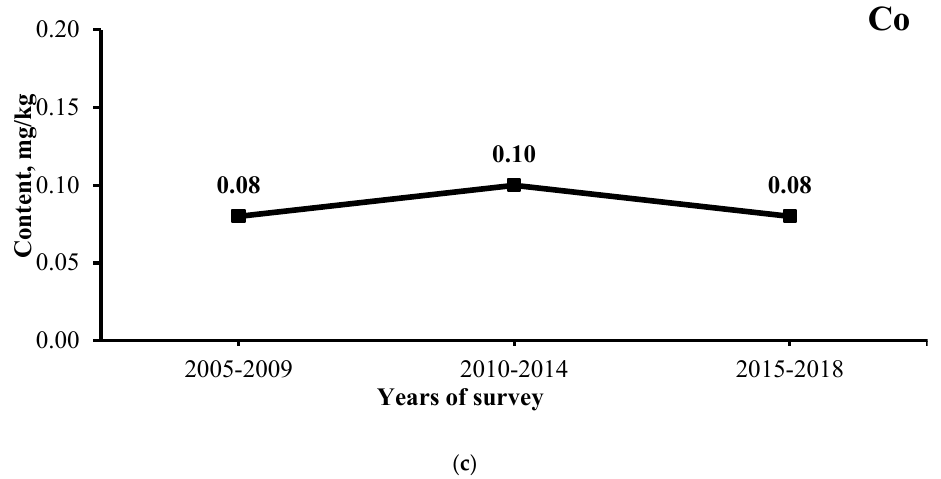
Figure 4. Dynamics of the weighted average contents of mobile forms manganese ( a ), zinc ( b ), and cobalt ( c ) in arable soils of Belgorod region, mg/kg.